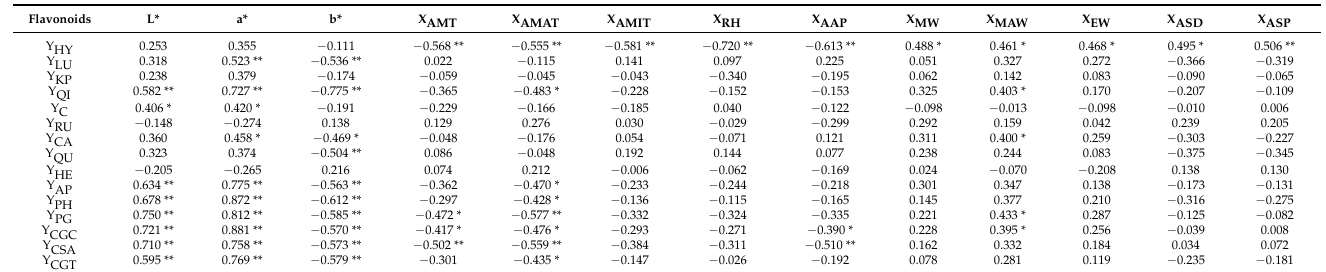
Table 2. Pearson correlation coefficients between color value, flavonoids and climate